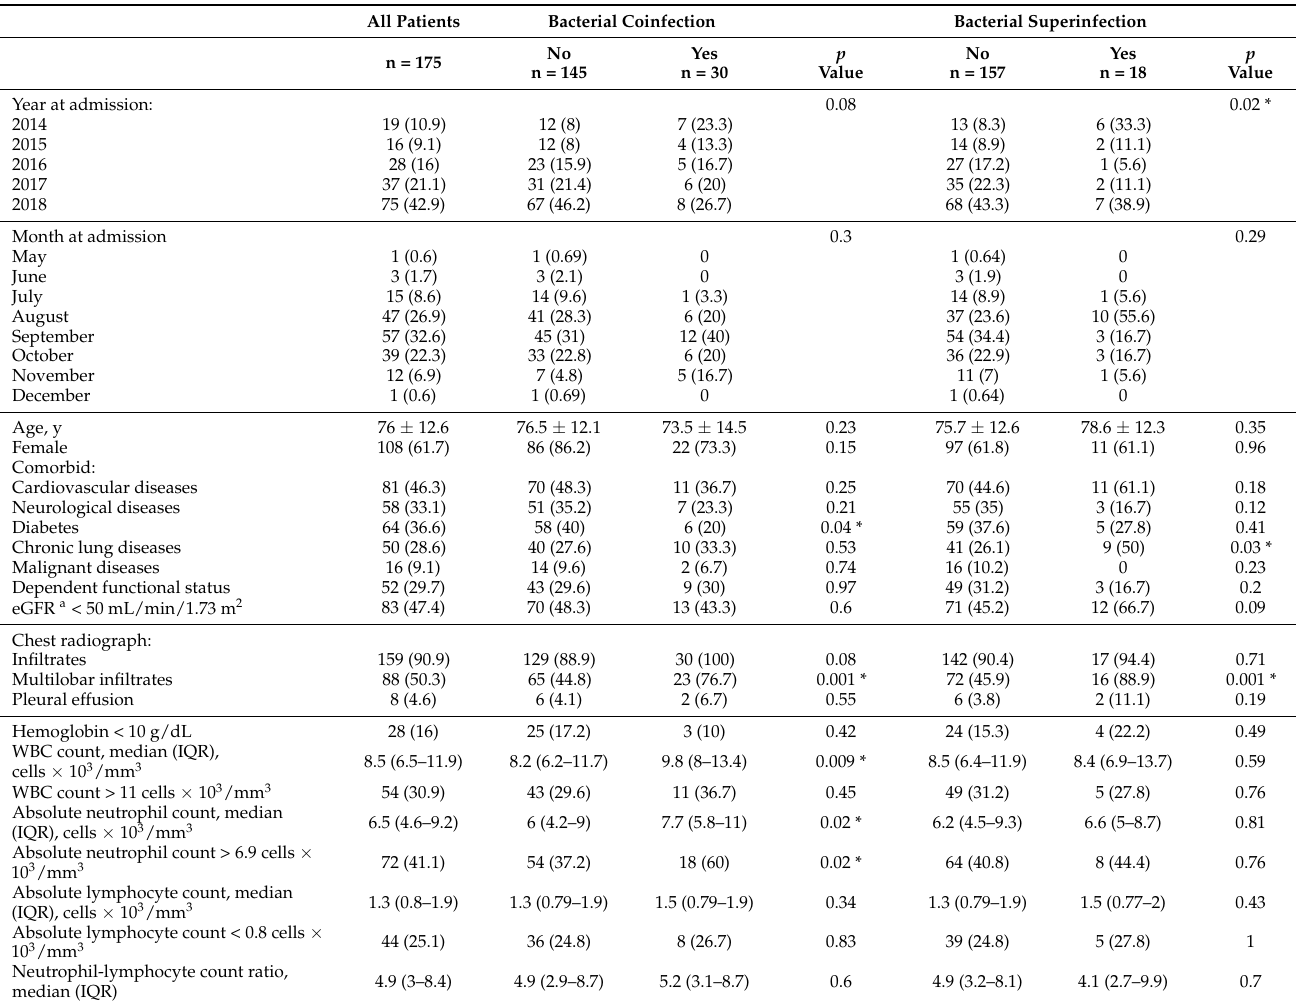
Table 1. Baseline characteristics and associated bacterial coinfection and bacterial superinfection of all patients hospitalized with respiratory syncytial virus-associated acute respiratory